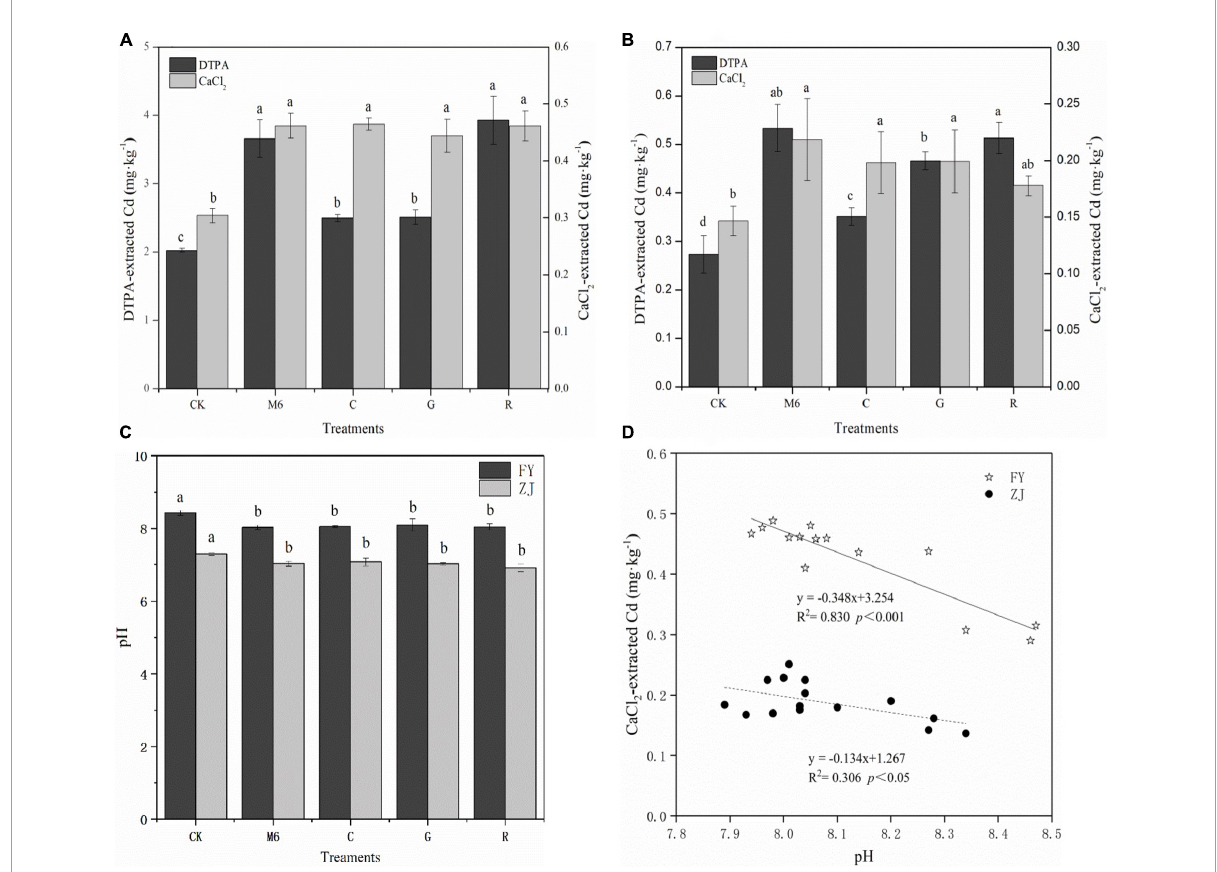
FIGURE2 Changes in pH and available cadmium in LC and HC soils. (A) Changes in extractable Cd of DTPA and CaCl 2 in HC soils; (B) changes in extractable Cd of DTPA and CaCl 2 in LC soils; (C) changes in soil pH; (D) correlation between soil pH and CaCl 2 -extracted Cd. The arrow bar above the line shows standard error. The different letters show significant differences while same letters represent no significant differences among the treatments. CK, control; M6, M6 strain; C, M6 + Biochar; G, M6 + Glutamic acid; R, M6 + rhamnolipid; FY, Fuyang; ZJ, Zhuji; LC, low cadmium; HC, high cadmium; DTPA, Diethyene triaminepenta acetic